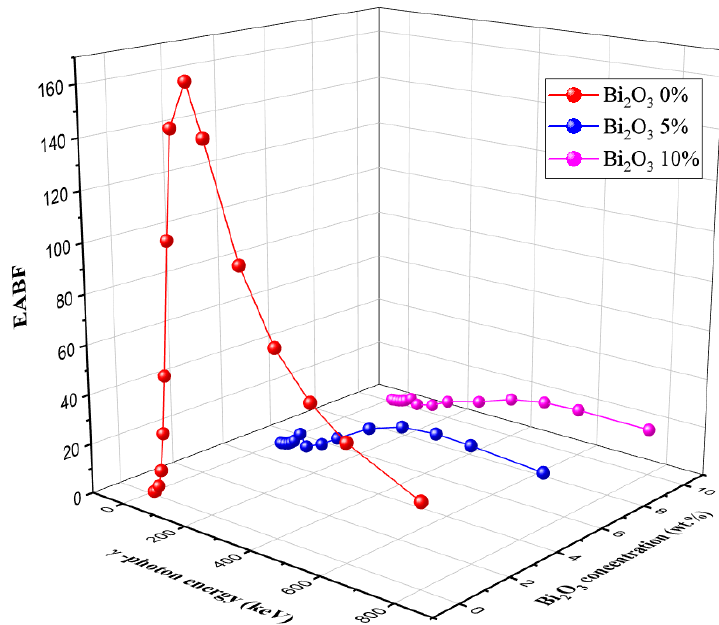
Figure 11. Variation in the EBF of the fabricated polyepoxide-reinforced Bi 2 O 3 composites versus the emitted γ -photon energy and Bi 2 O 3 concentration.